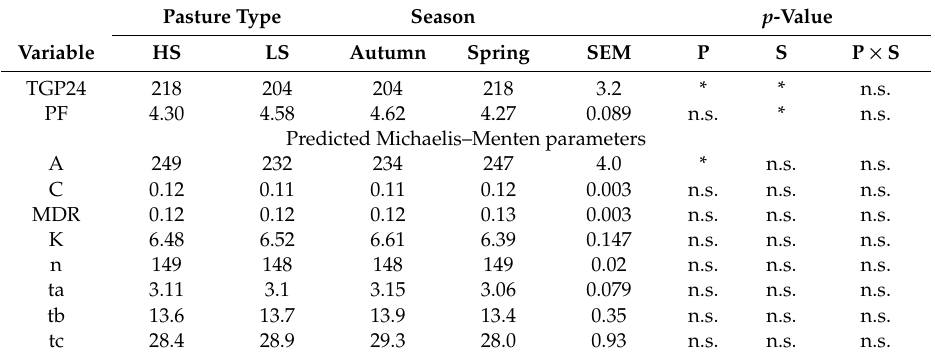
Table 2. E ff ect of pasture type and season on in vitro gas production kinetics. Pasture Type p